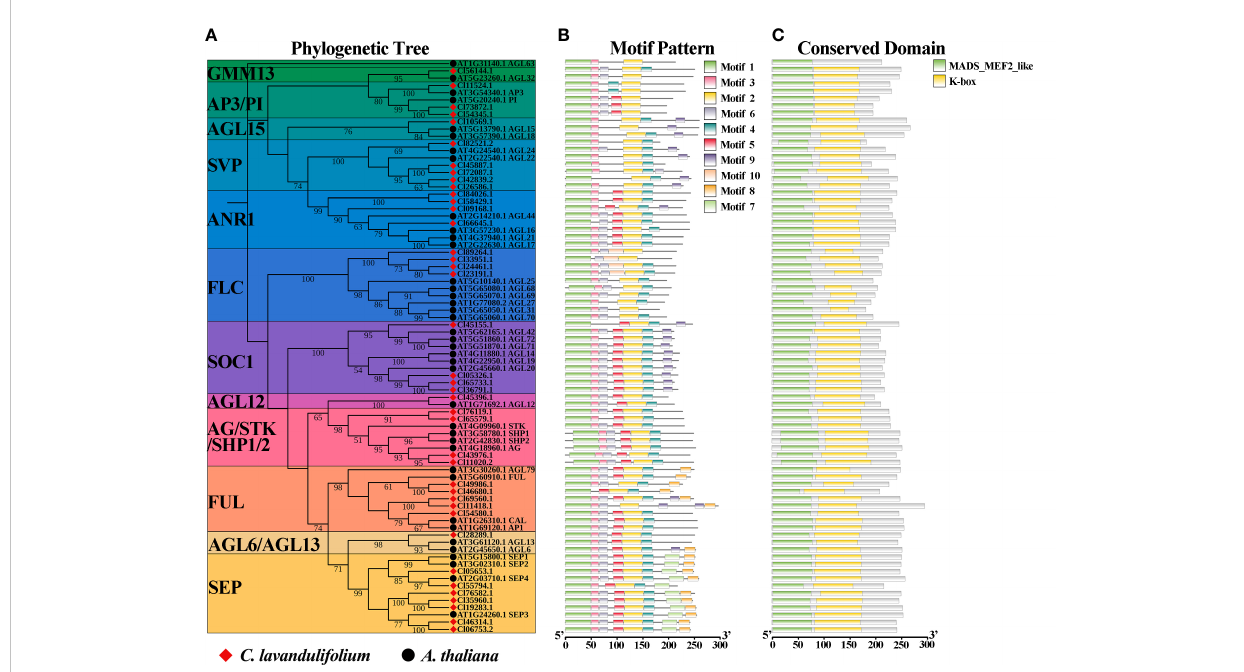
FIGURE 3 Analysis of phylogenetic, conserved motifs, and conserved structural domains of ClMIKCc and AtMIKCc. (A) ML phylogenetic tree of ClMIKCc and AtMIKCc. The number above branches represented bootstrap value and the values below 50 would not be shown; (B) Conserved motifs in ClMIKCc and AtMIKCc, 10 predicted motifs are indicated by different colored squares; (C) Conserved structural domains in ClMIKCc and AtMIKCc, 2 predicted structural domains are indicated by squares of different